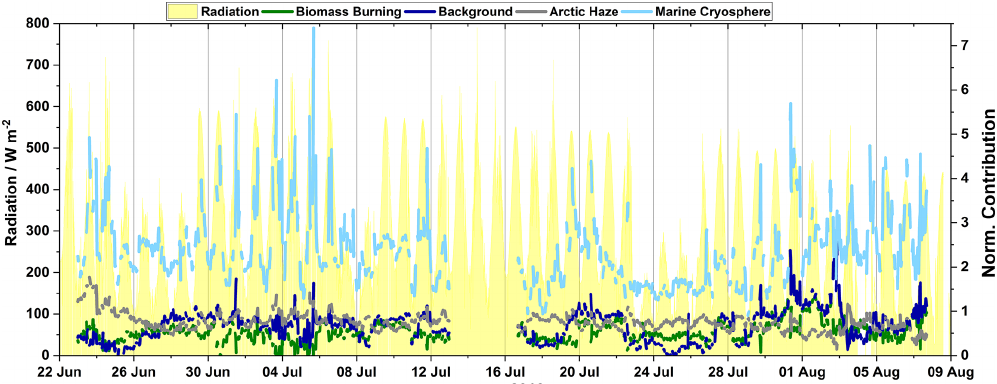
Figure 6. Time series of the four factors from 22 June–9 August displaying the diurnal profile together with